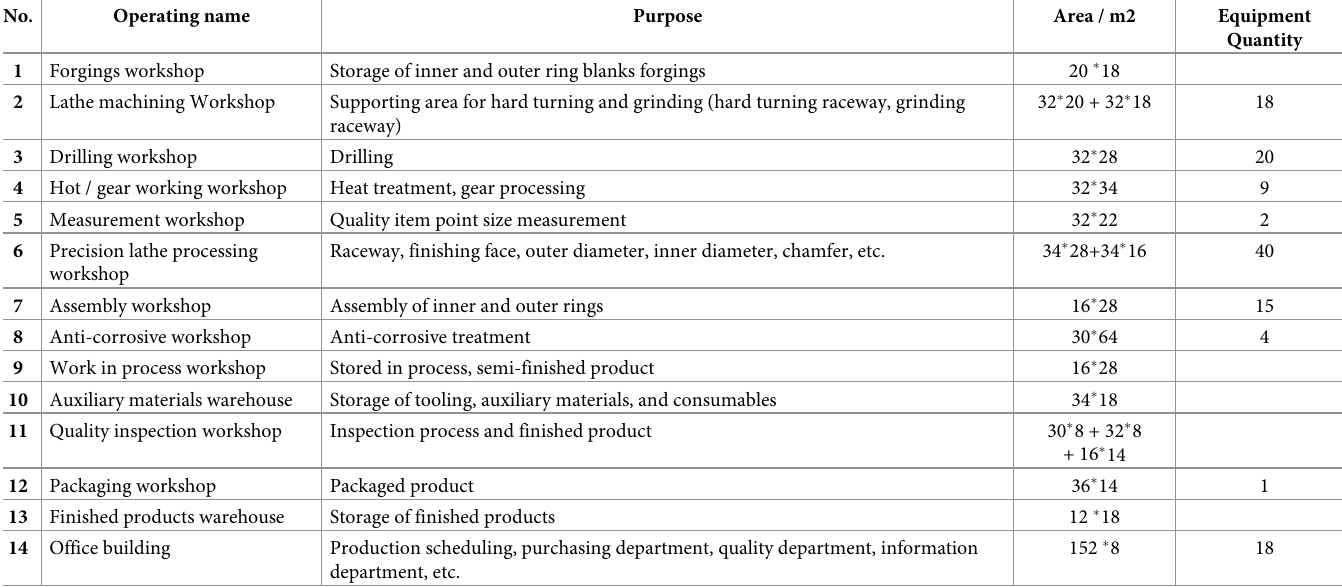
Table 1. Workshop/Warehouse area and number of